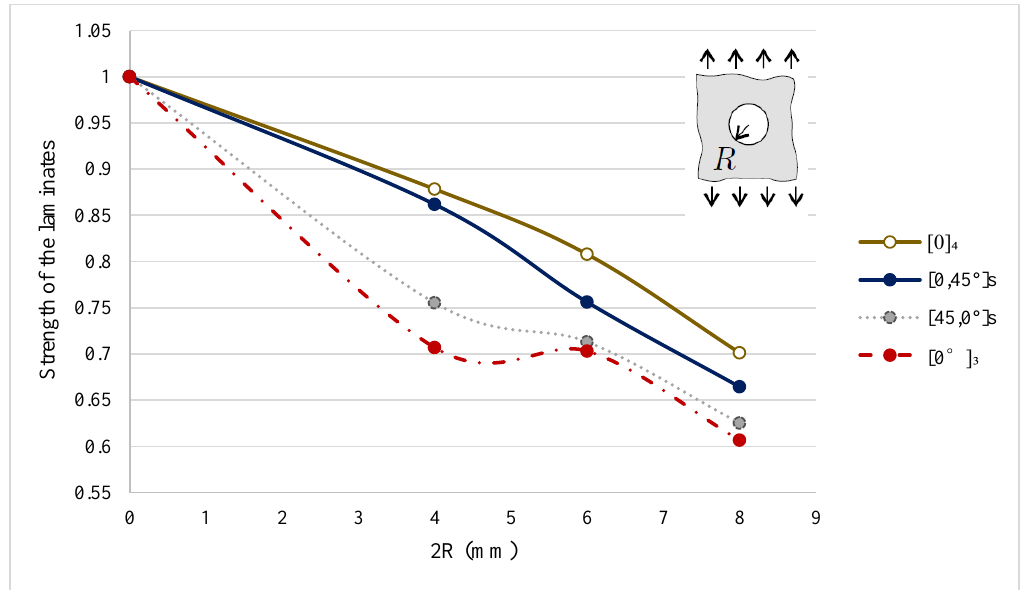
Figure 7. Strength of the laminates ( σ N ∞ / σ O ) vs. size of the circular hole (2 R ) in the center of the laminates.